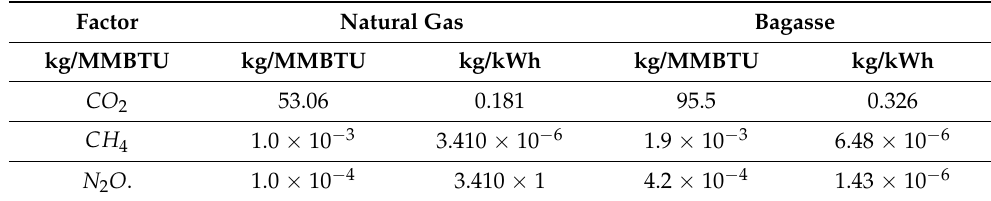
Table 5. Emission factors for greenhouse gas inventories. Factor Natural Gas